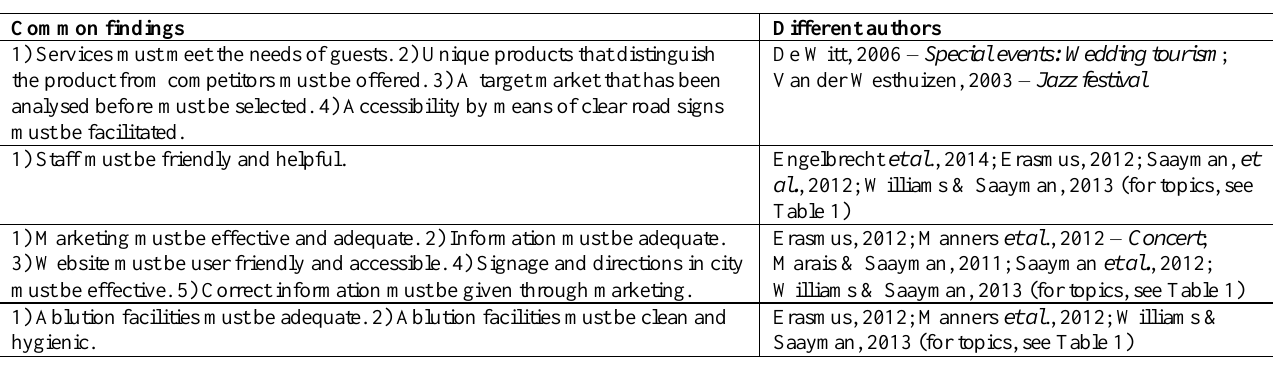
Table 2: Common findings of previous research on critical success factors in the tourism field Common